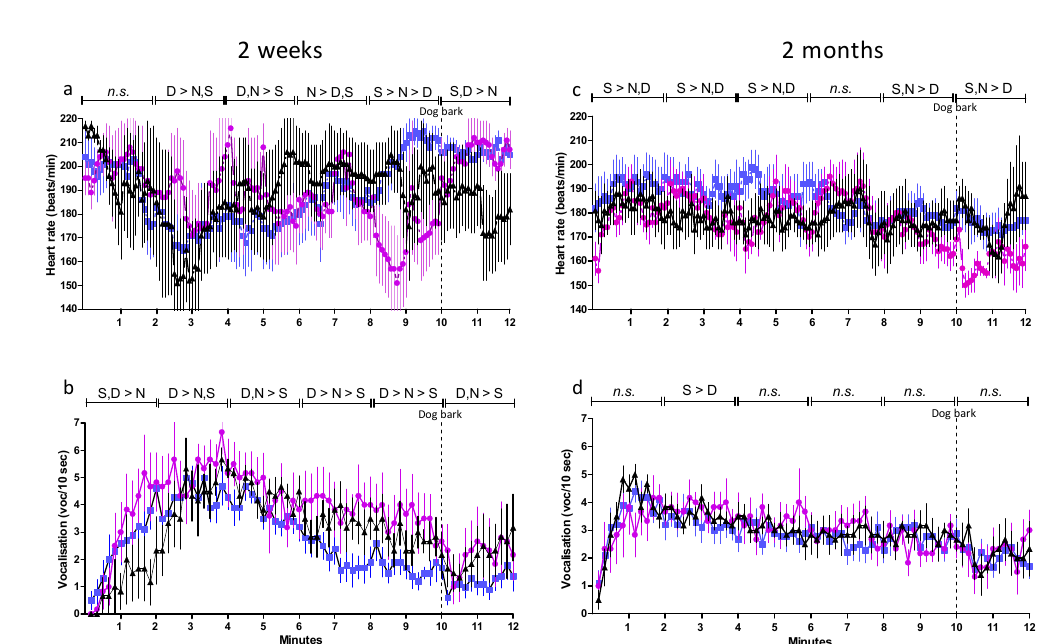
Figure 1. Heart rate and vocalization frequency at two weeks ( a , b ) and two months ( c , d ) (means ± SEM) in SEP kids ( ) DAY-SEP kids ( ) and NON-SEP kids ( ) during 12-min isolation test with the sound of a dog bark at 10 min. SEP = (S) 10 kids separated from their mother, DAY-SEP = (D) 6 kids separated from their mother between 7.30 h–15.00 h, and NON-SEP = (N) 6 kids kept together with mothers. > indicates significant differences between treatments stated in the figure. The level of significance was set at p ≤